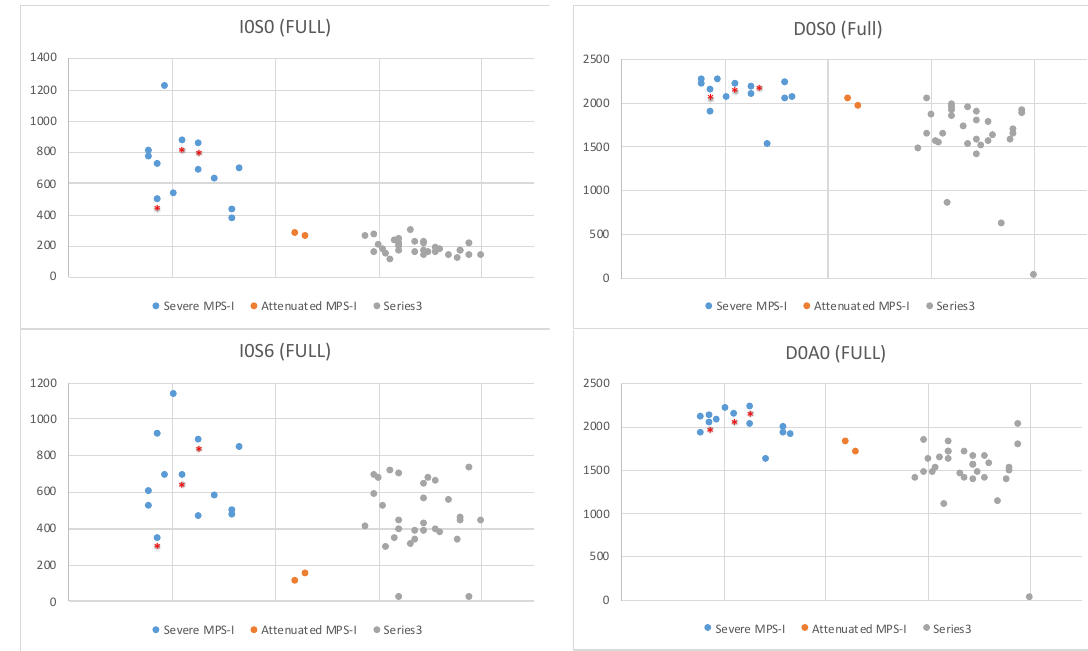
Figure 6. Sensi-Pro markers (I0S0 and I0S6) in DBS from 30 random newborns (non-MPS-I), 13 severe MPS-I newborns, and two attenuated MPS-I newborns. The level of internal disaccharide markers D0A0 and D0S0 measured in the same LC-MS/MS run are also shown. Asterisked dots are from newborn DBS that were stored at ambient temperature, all others were stored frozen.